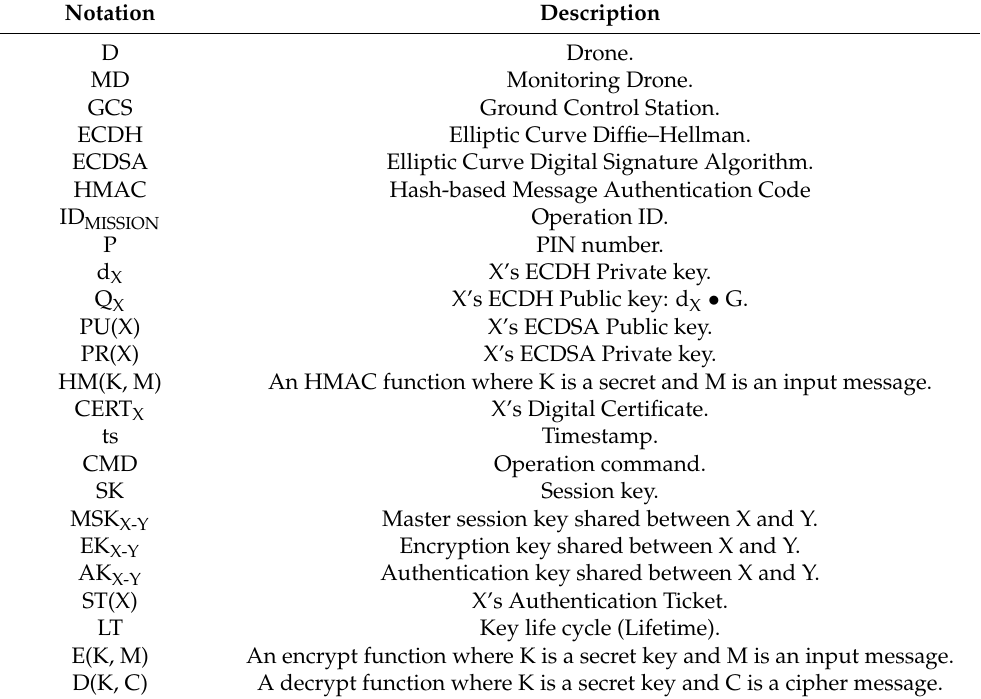
Table 1. Notations and their